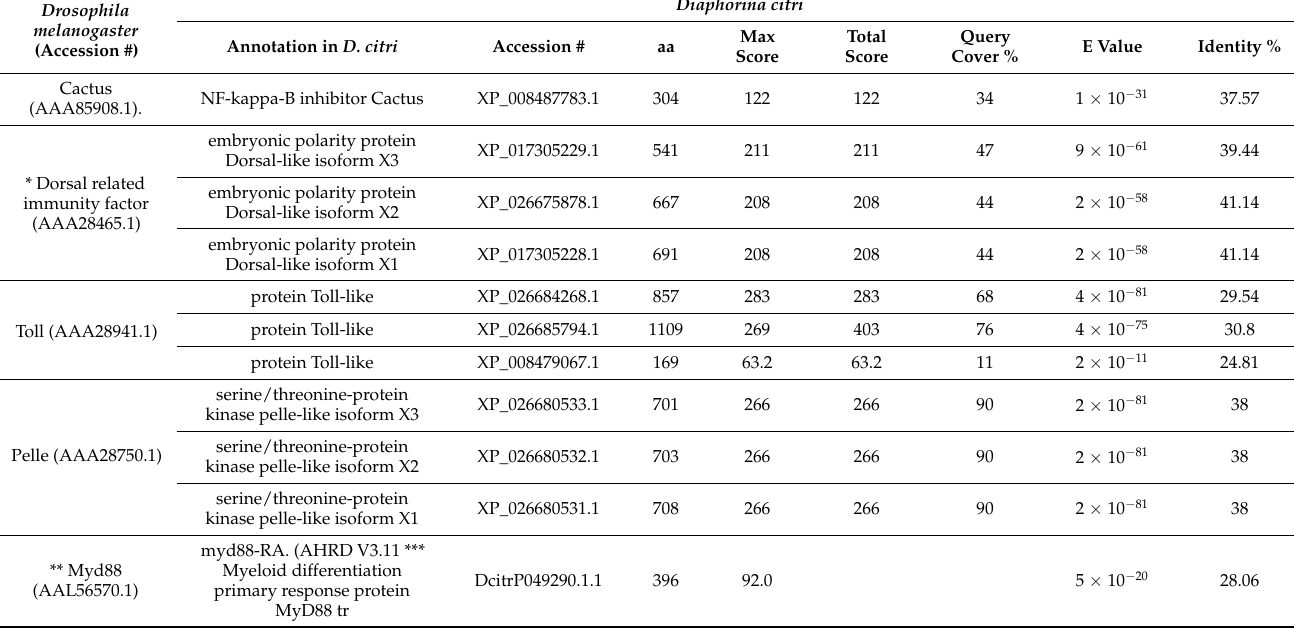
Table 2. Alignment statistics for the top-matched sequences producing significant alignments of Toll system